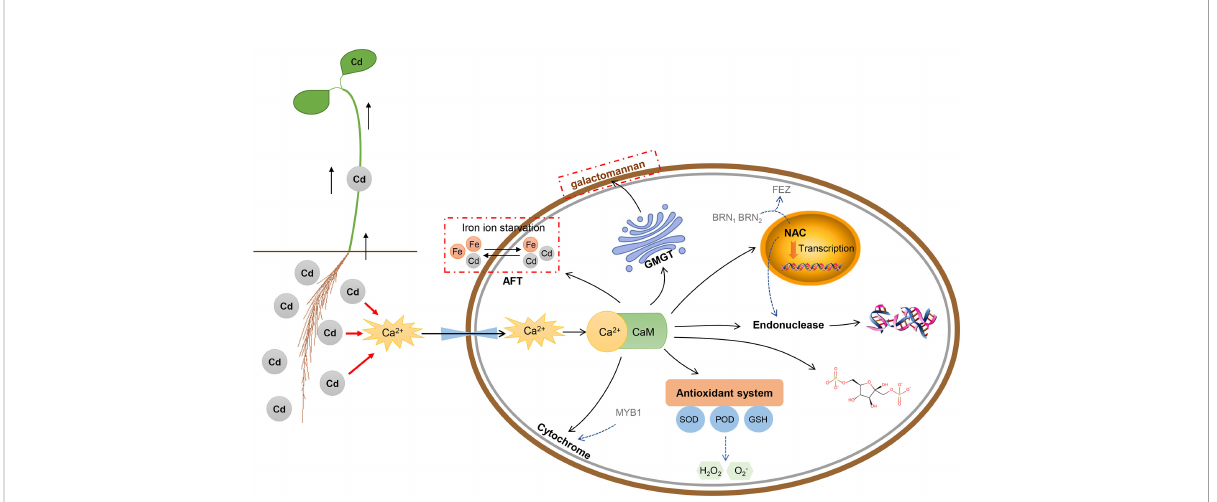
FIGURE 12 The schematic representation of the physiological and molecular processes induced by Cd stress in Tartary buckwheat roots cells. The CaM-binding domain can transduce the Ca 2+ signal by combining with Ca 2+ to form a Ca 2+ -CaM complex, then trigger a series of reactions downstream like antioxidant activity, metal ion binding, plant-type secondary cell wall biogenesis, regulation of transcription, and nucleic acid